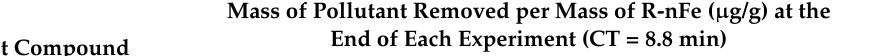
Table 4. The ratio of mass of pollutant removed per mass of the nanocomposite material (R-nFe) at the end of each experiment, conducted with two different initial concentrations of the pollutants (without pH adjustment and at a contact time of 8.8